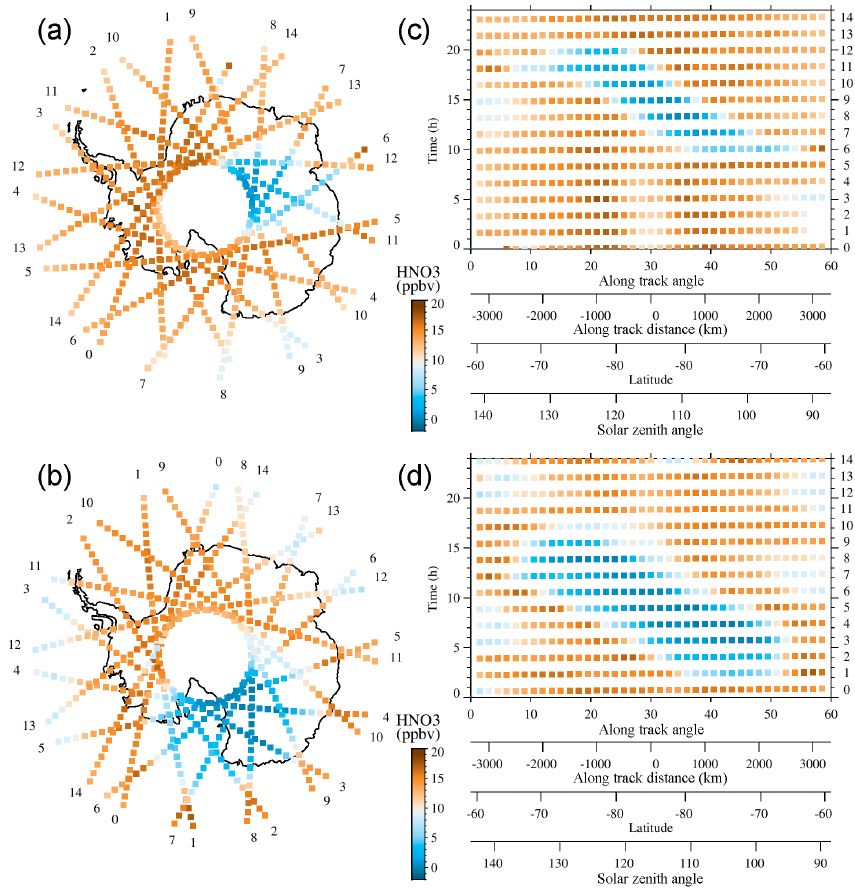
Figure 2. (a) Polar stereographic projection of the MLS measurement locations for all orbits over the Antarctic on 2009d146 (26 May 2009). Each orbit is numbered sequentially. The square symbols denote the latitude and longitude locations of the MLS vertical profiles. The size of the squares is not representative of the along-track or across-track resolutions. The HNO 3 volume mixing ratio at 32hPa is given by the color bar. (c) The same data points are shown as a temporal raster plot. The ordinate is the time of day in hours (UT) and the abscissa is the geodetic along-track angle. The squares denote the time of day of the MLS measurement and the measurement location with respect to the closest approach of the orbit track to the South Pole. Each orbit is numbered along the right ordinate. Also shown are the along-track distance, the latitude, and the solar zenith angle. The size of the squares is not representative of the MLS integration time or the along-track resolution. (b, d) As for (a, c) , except for 2009d156 (5 June